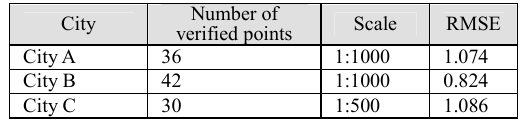
Table 4. Verification result of location accuracy of house